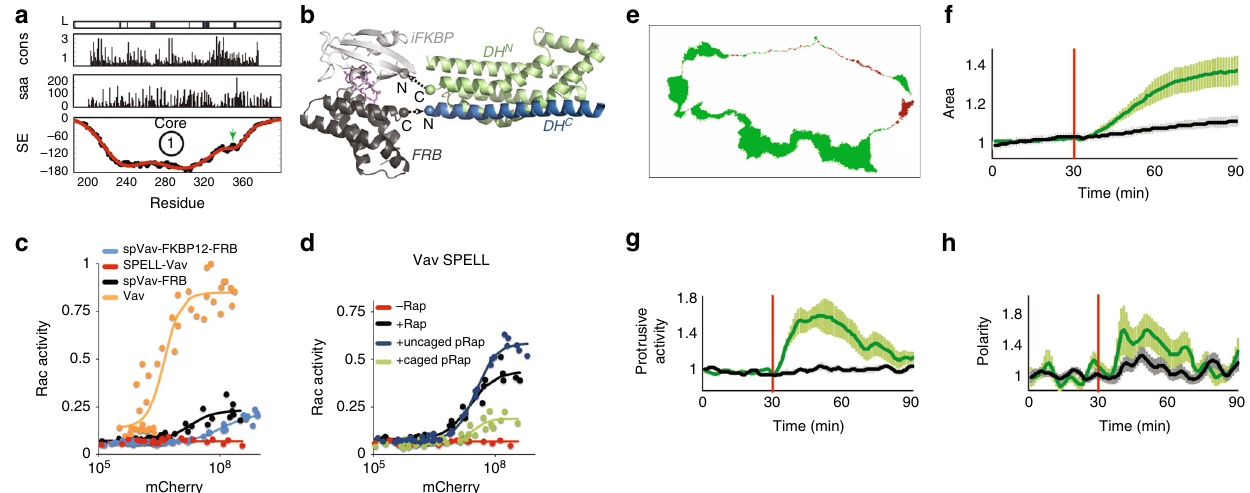
Fig. 4 Activation of Vav2 SPELL leads to cell protrusion. a Split energy pro fi le of the DH domain of Vav2. Green arrow shows the least destabilized region and chosen loop for splitting. cons = sequence conservation, saa = surface exposure. b A structural model of Vav2 SPELL. iFKBP (light gray) was fused to the C terminus of the N-lobe of the DH domain (green), and FRB (dark gray) was fused to the N terminus of the C-lobe of the DH domain (blue) in the presence of rapamycin (purple). c A dual chain Rac1 FRET sensor was used to test Vav2 analogs. The FRET ratio (re fl ecting the activity of Rac1) with respect to the amount of mCherry-labeled Vav2 proteins: spVav-FKBP12-FRB = split protein generated using FKBP rather than iFKBP (mCherry-DH N - FKBP12 and FRB-DH C -PH-ZnF), Vav2 SPELL (mCherry-DH N -iFKBP and FRB- DH C -PH-ZnF), spVav-FRB = split protein made with no FKBP (mCherry-DH N and FRB- DH C -PH-ZnF), and Vav2 (mCherry-DH-PH-ZnF). d Vav2 SPELL activated with rapamycin or caged rapamycin, assayed as in c . e A HeLa cell expressing Vav2 SPELL, showing protrusion (green) and retraction (red) 19 min after rapamycin addition (upper left). f , g , h Morphology parameters (area, protrusive activity, and polarization index) of cells expressing Vav2 SPELL (green, mean ± s.e.m., n = 19 cells) vs. cells expressing only membrane marker (black, mean ± s.e.m., n = 36 cells). Rapamycin was added at 30 min (red